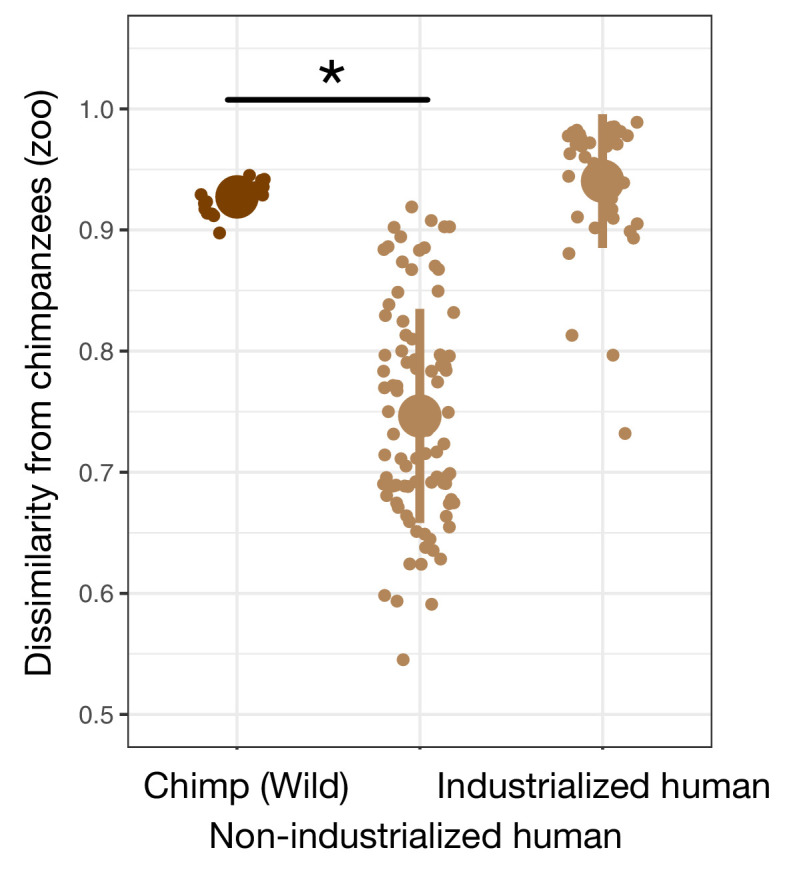
Dissimilarity in the gut microbiota among chimpanzees and humans.Bray–Curtis dissimilarity among samples taken from captive zoo chimpanzees, wild chimpanzees, and human populations shows that the gut microbial communities of captive chimpanzees are more similar to those of non-industrialized humans, but not industrialized humans, than to those of wild chimpanzees. * indicates p<0.05, Bonferroni-corrected Mann–Whitney U test comparing to wild chimpanzees; all groups were statistically greater than zoo chimpanzees’ dissimilarity to other zoo chimpanzees. Large shapes are means; bars show standard deviations.